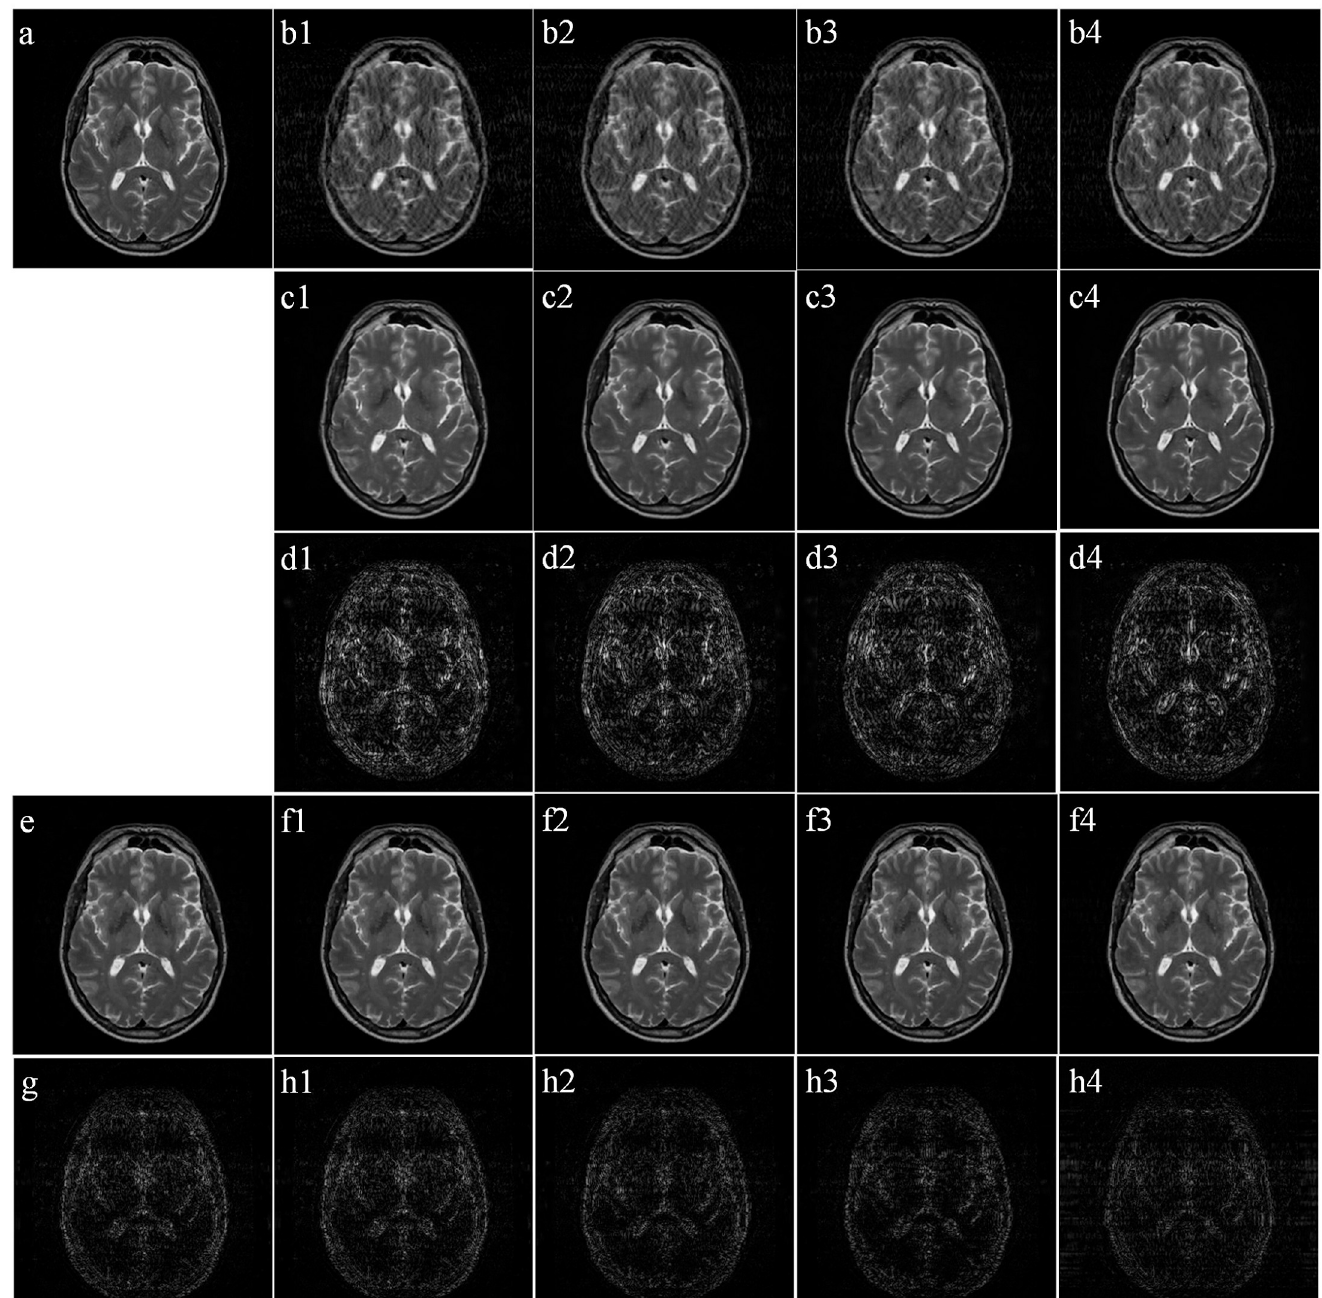
Fig 6. Final images reconstructed using the proposed algorithm. (a) Reference image without motion; (b1), (b2), (b3), and (b4) are the simulated motion-corrupted images for motion mode M35, M40, M45, and M50, respectively; (c1), (c2), (c3), and (c4) are the filtered images by trained CNN model for (b1), (b2), (b3) and (b4), respectively; and (d1–d4) are the corresponding difference images (5 × ) between images (c1–c4) and the gold standard (a). (e) Image reconstructed using CS directly using 35% under-sampled data; (f1), (f2), (f3), and (f4) are the images constructed using the proposed method for M35, M40, M45, and M50, respectively; and (g, h1– h4) are the corresponding difference images (5 × ) between images (e, f1 –f4) and the gold standard (a).